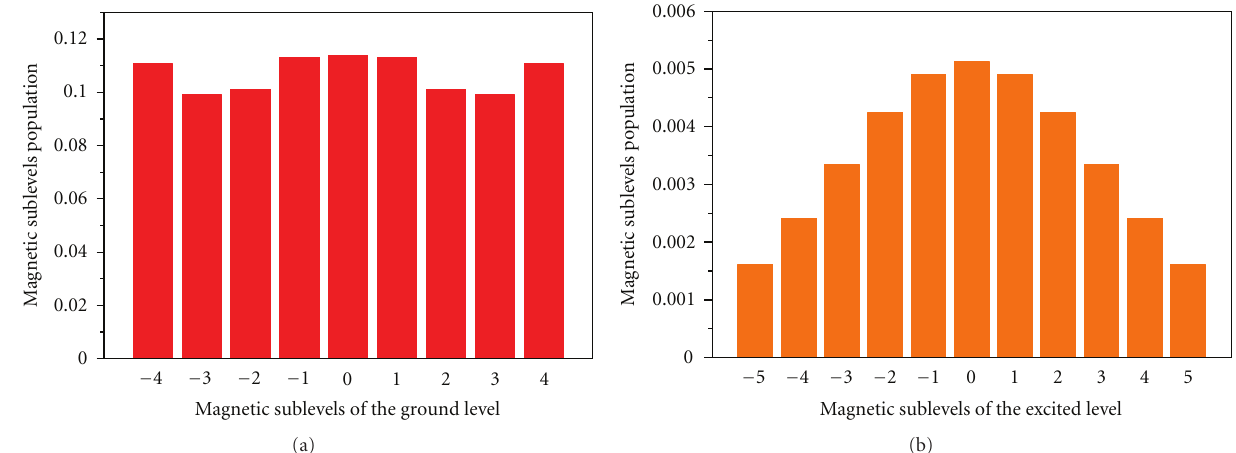
Figure 9: Illustration of the atomic population distribution between the Zeeman sublevels of the ground level F g = 4 (a) and of the F e = 5 excited level (b), for the F g = 4 → F e = 5 transition. The collision rate leading to the population density redistribution used is of 10MHz. Note the essential change in the atomic population distribution on the ground level magnetic sublevels compared to the case of the absence of elastic interactions (Figure